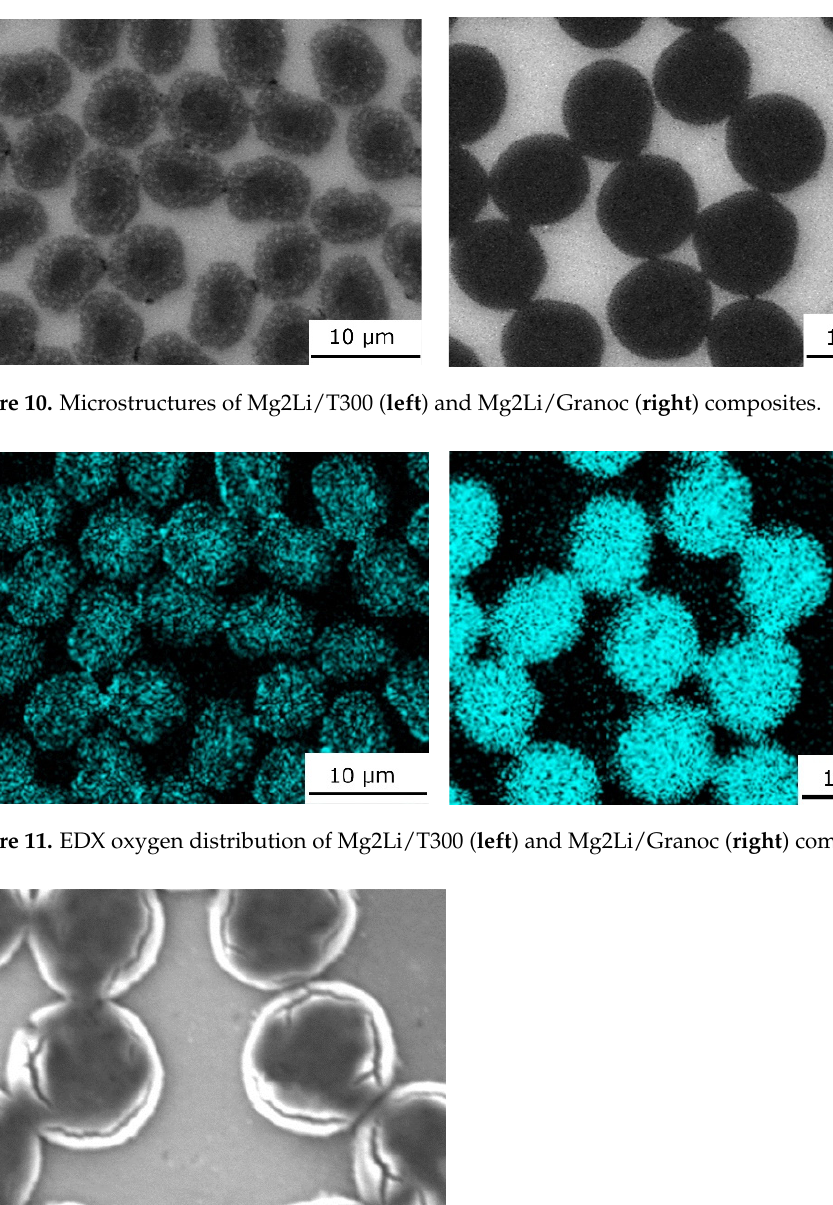
Figure 13. SEM images of Mg1.8Y/Granoc ( left ) and Mg2Li/Granoc ( right ) composites after thermal exposition in the DMA apparatus.